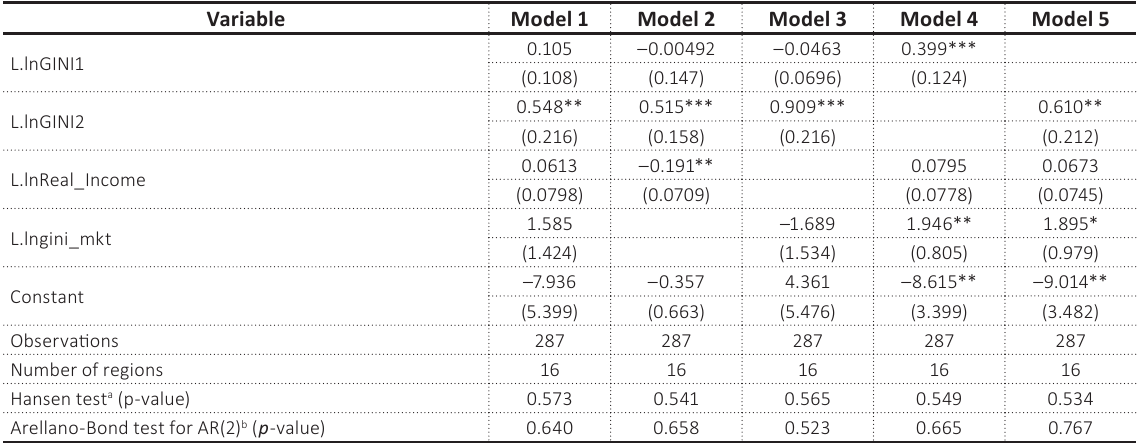
Source: Compiled by